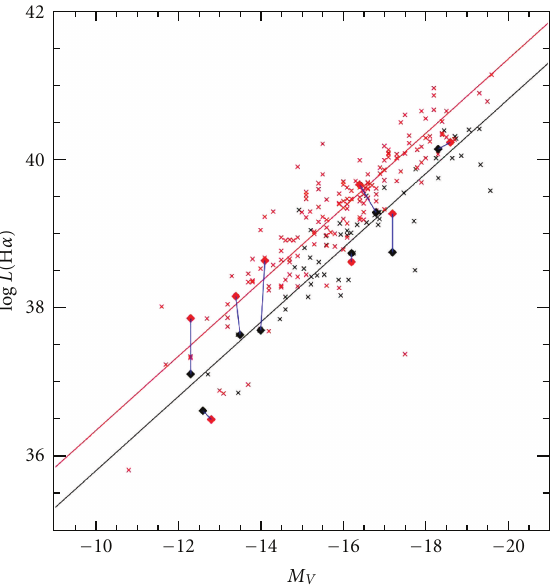
Figure 8: Comparison between H α fluxes from Hunter and Elme- green and this study. The blue line delineates a 1-to-1 correspond- ence. The average di ff erence is 0.15 in log flux, and the standard deviation is 0.4 in log flux.